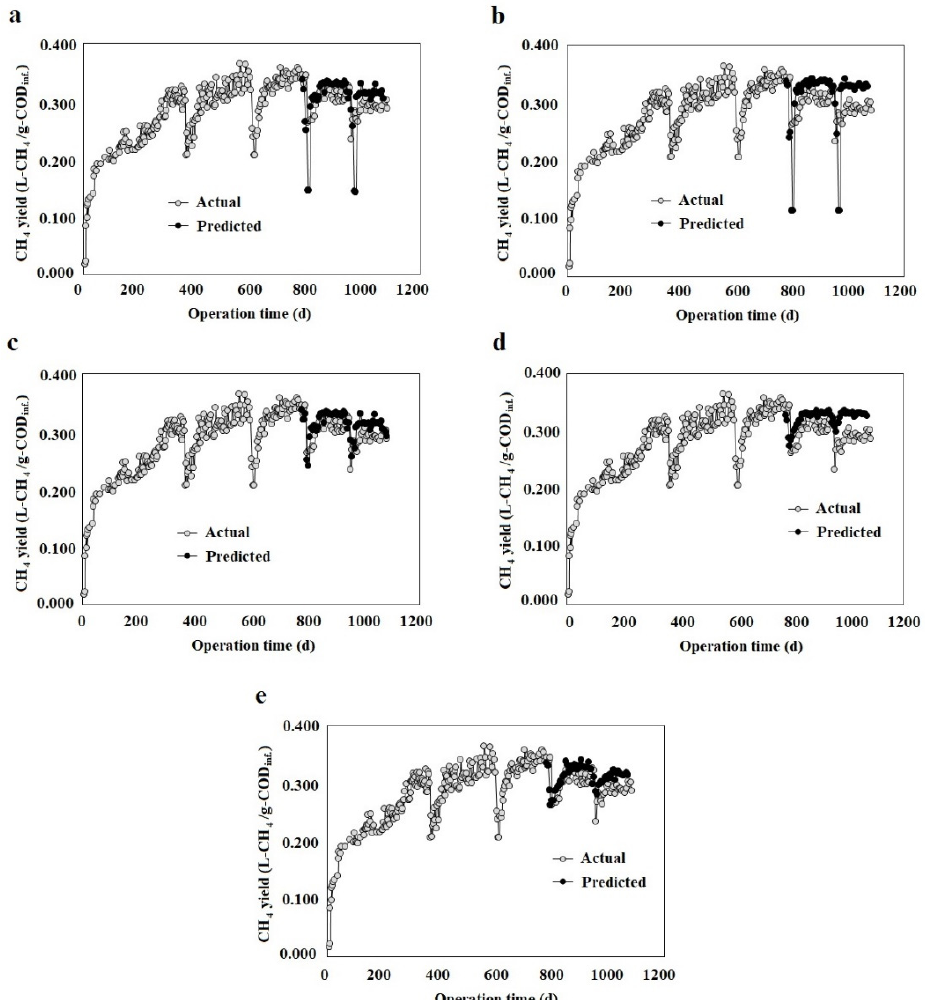
Figure 4. Results of the multi-step ahead predictions prediction of bio-electrochemical anaerobic digestion (BEAD) reactor using ( a ) random forest (RF), ( b ) extreme gradient boosting (XGboost), ( c ) support vector regression (SVR), ( d ) long short-term memory (LSTM), and ( e ) recurrent neural network (RNN) models.